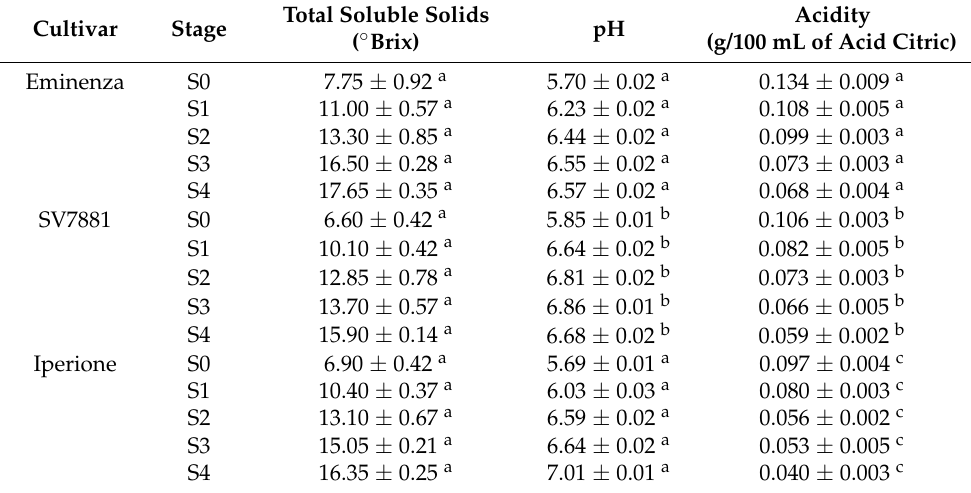
Table 1. Total soluble solids, pH, and titratable acidity in Eminenza, SV7881, and Iperione at five ripening stages